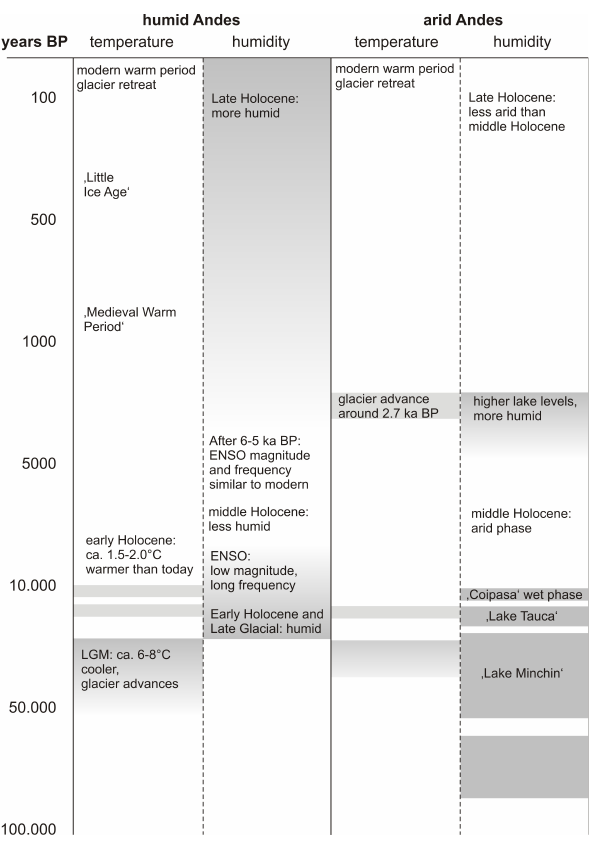
Fig. 6. Overview of climate changes in the humid and arid Andes during the late